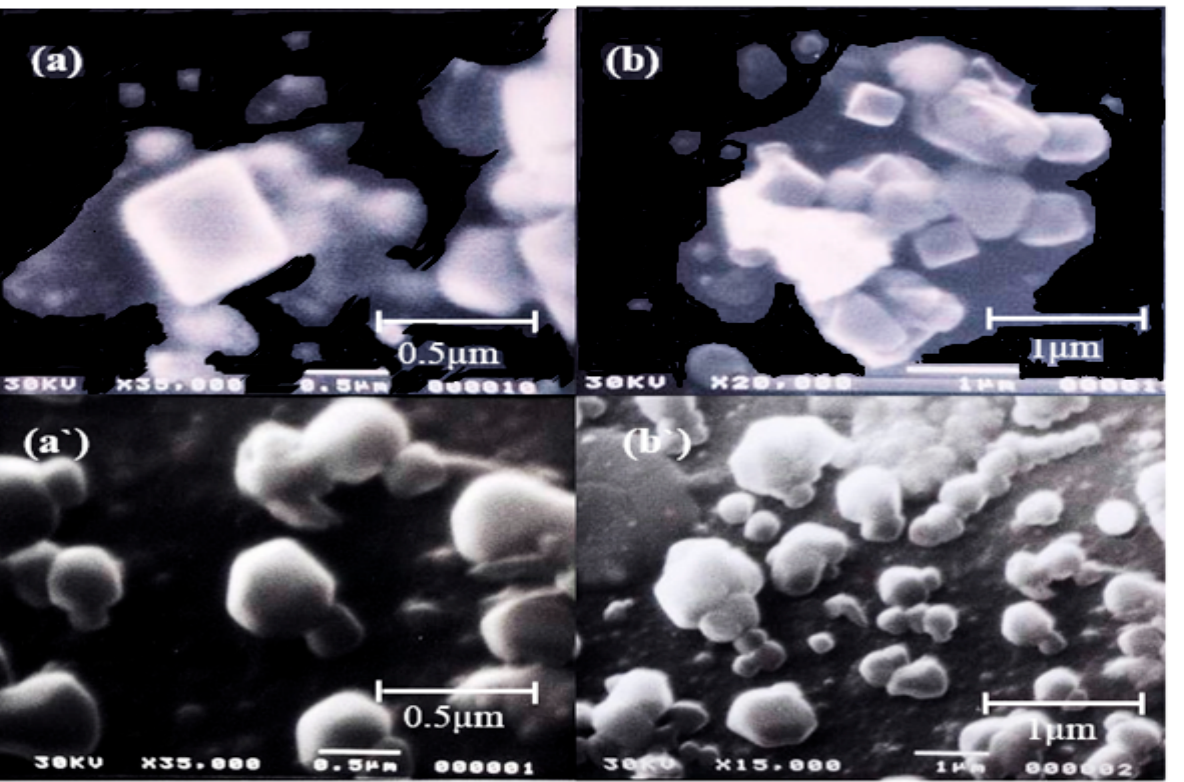
Figure 5. ( a , b ) SEM micrographs of as ‐ deposited IR ‐ PLD CdS thin film, ( a` , b` ) SEM micro ‐ graphs of IR ‐ PLD CdS thin film annealing at 300 °C.